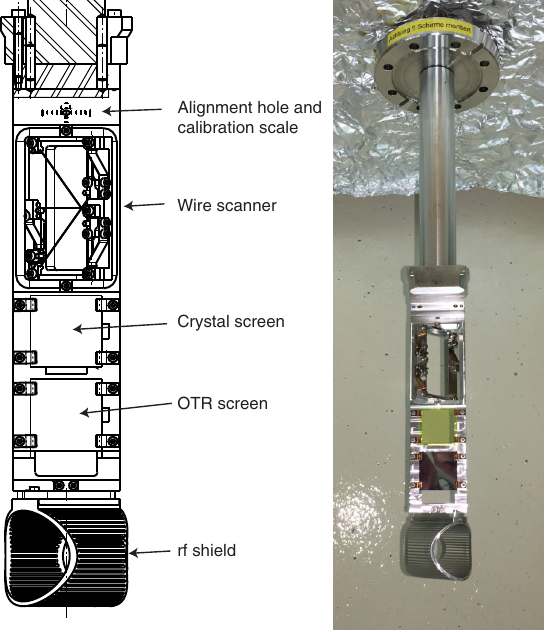
FIG. 33. Technical drawing and photograph of the ultra-high- vacuum feedthrough insertion accommodating alignment targets, three scanning wires, two screens (crystal scintillator and OTR), and an rf